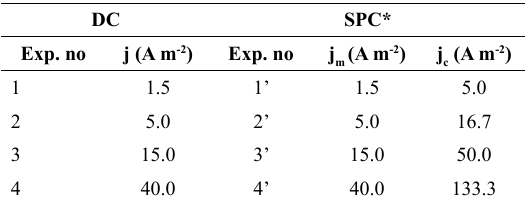
Table 1. Conditions used to produce the electrodeposited Cu-Co coatings using DC and SPC